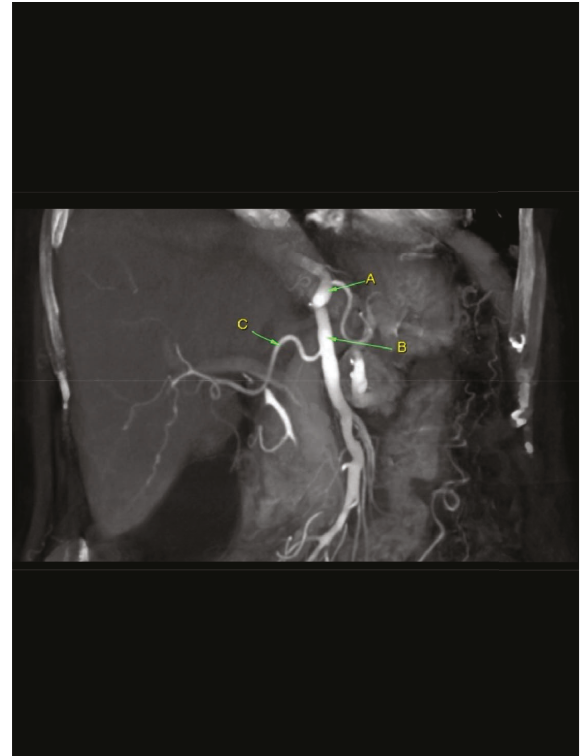
Figure 6: Incomplete CMT: hepato-mesenteric variant showing a replaced right hepatic artery (C) arising from the superior mes- enteric artery (B) instead of the celiac trunk